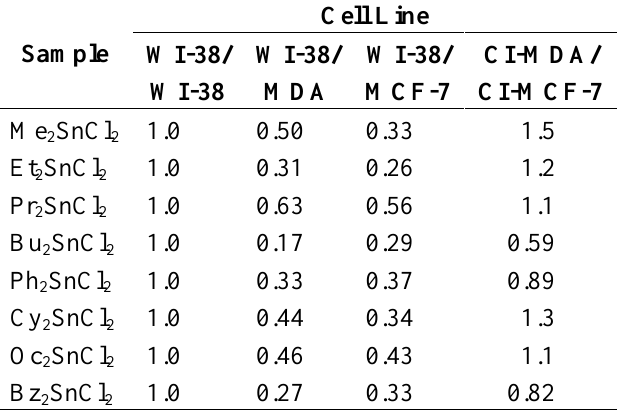
Table 8. Chemotherapeutic Index-50% for organotin monomers for MDA and MCF-7 cell